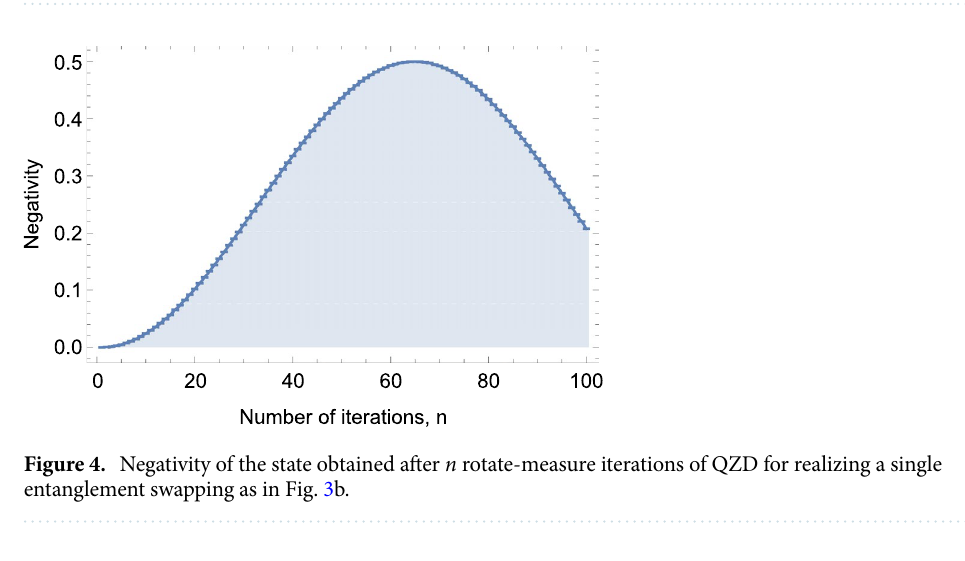
Figure 3. Entanglement swapping procedure via ( a ) the usual circuit model consisting of a CNOT and a Hadamard gate, ( b ) the proposed QZD strategy consisting of only single qubit rotations and simple threshold measurements, requiring no controlled two-qubit gates.